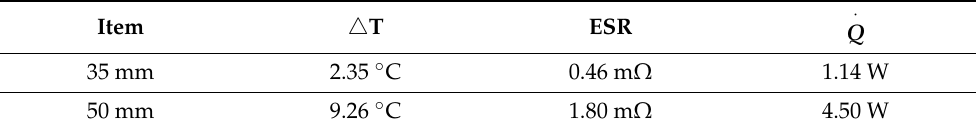
Figure 2. Film width 35 mm ( left ) versus 50 mm ( right ) finite element analysis results. Table 3. Analysis results for 35 mm and 50 mm